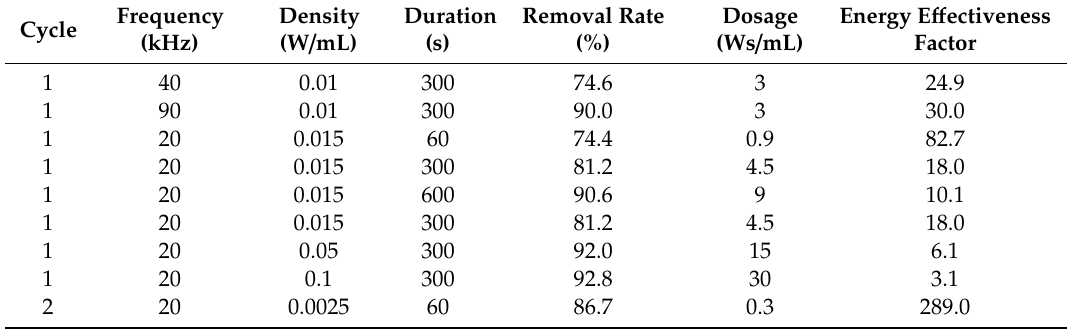
Table 1. Ultrasonic parameters, dosage and energy effectiveness factors of the experimental groups. Cycle Frequency